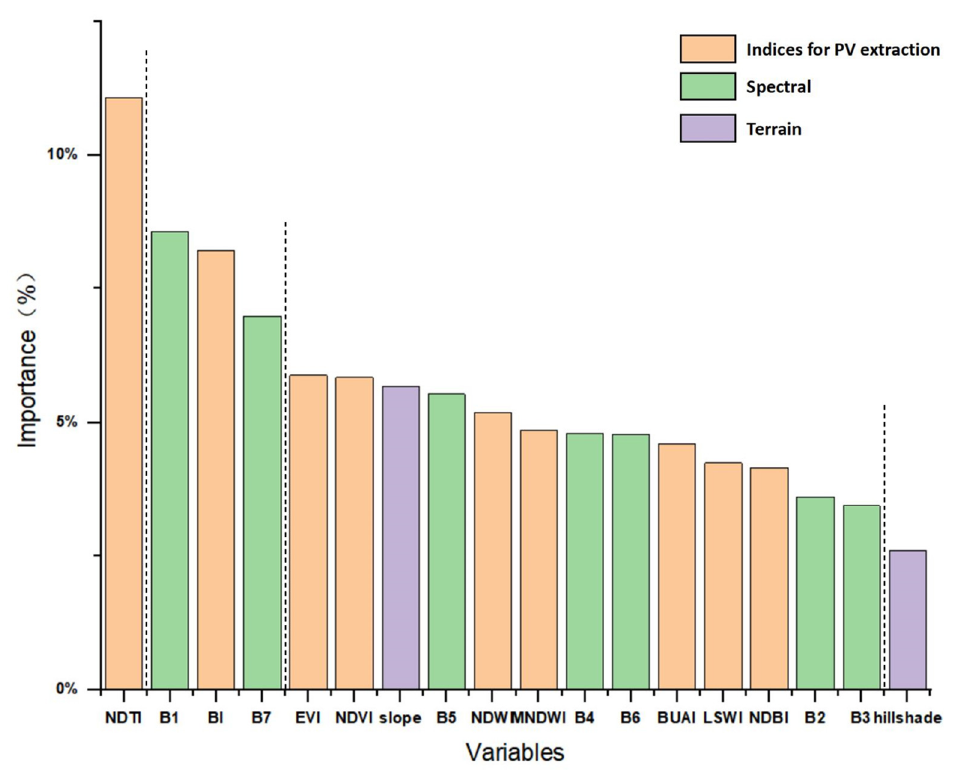
Figure 9. Plot highlighting the importance of different variables involved in the XGBoost model.